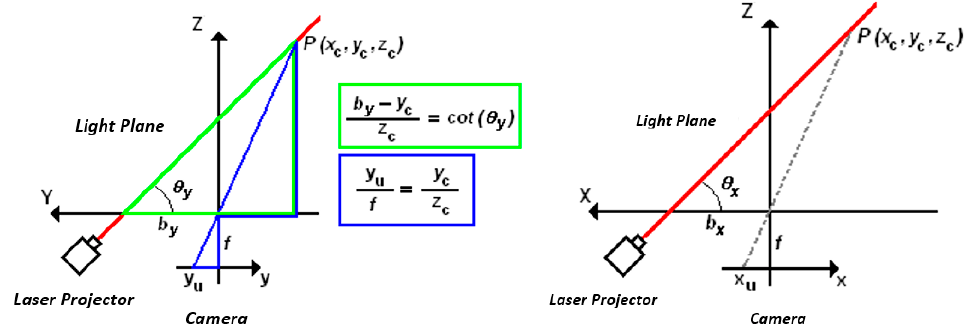
Figure 3. A light plane and the image formation of a point on the first and second laser line, showing the triangulation from the laser projection on the object surface.